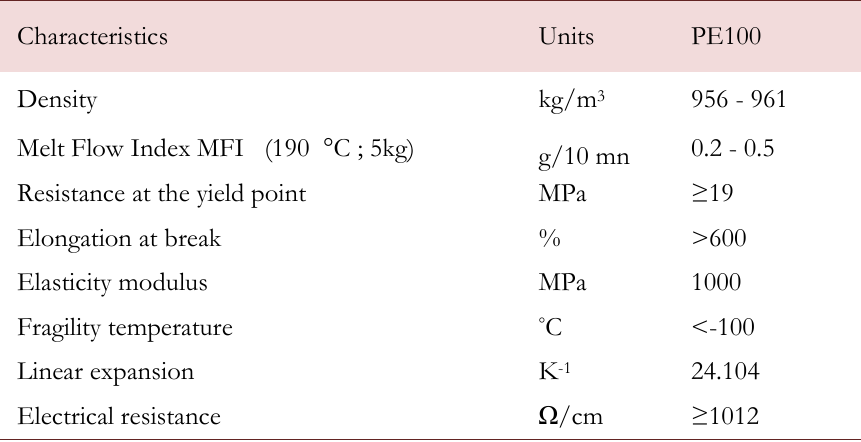
Table 1: Physical and mechanical characteristics of HDPE [38,